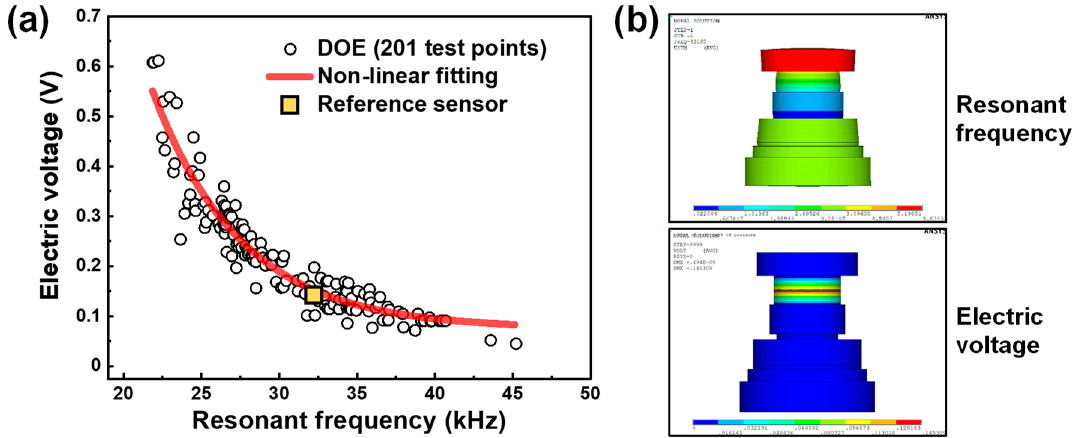
Figure 2. ( a ) Plot for electric voltage vs. resonant frequency obtained from 201 test data by design of experiments (DOE); ( b ) Simulation results of resonant frequency and electric voltage for reference sensor design.